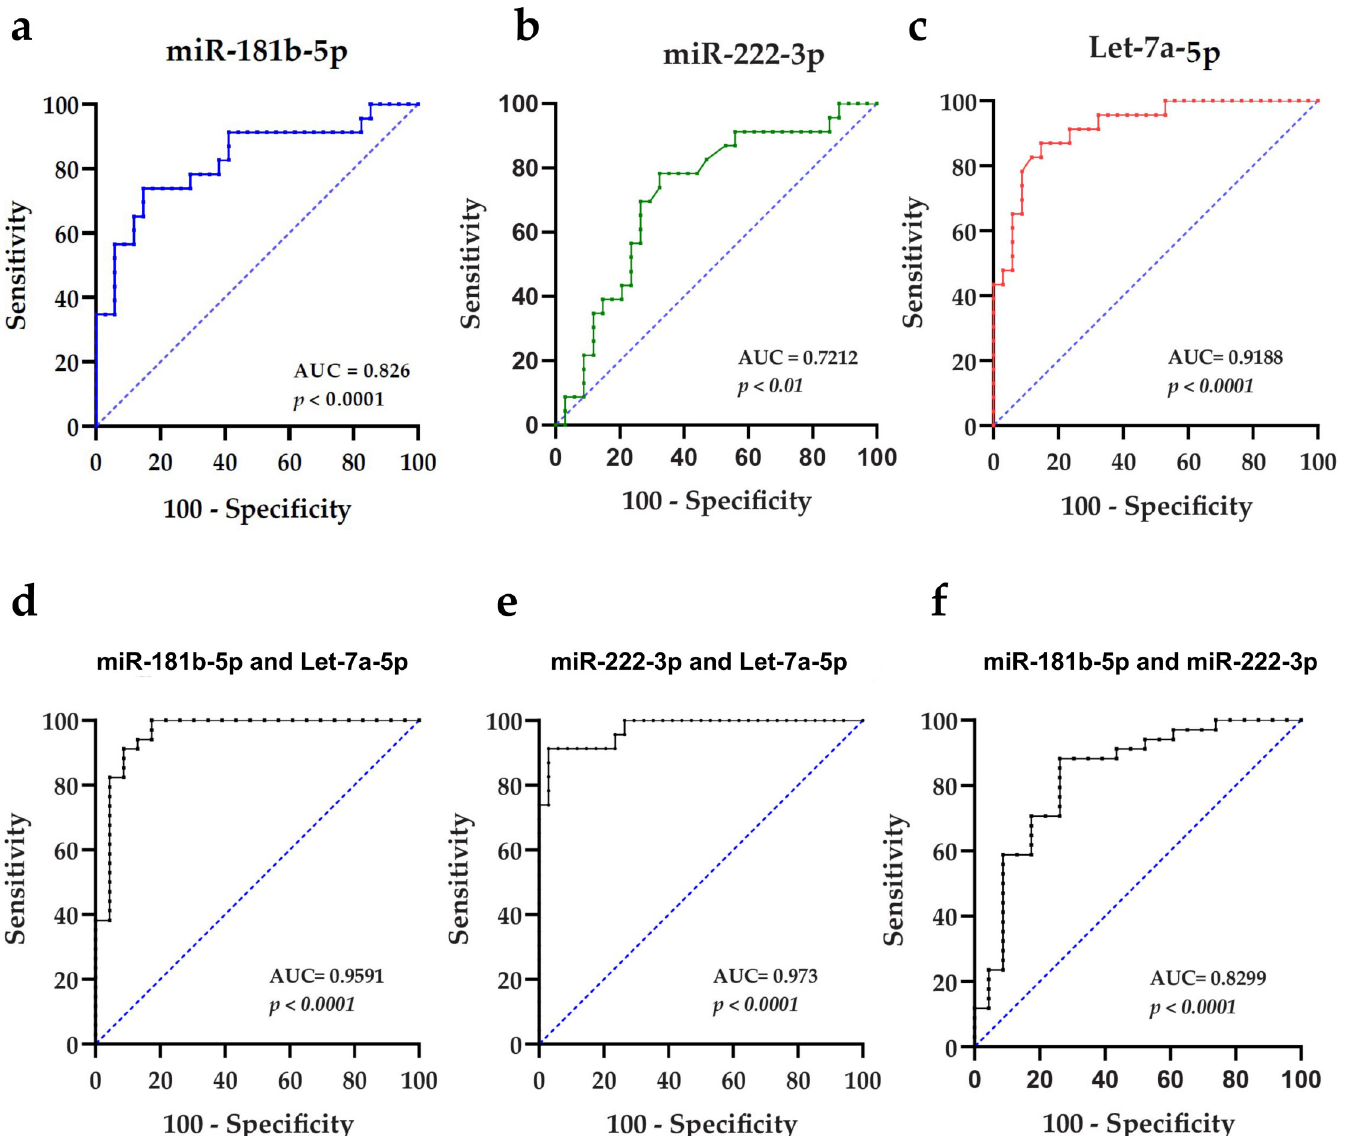
Fig 7. ROC curves generated using expression levels of miR-181b-5p, miR-222-3p, and let-7a-5p. (a-c) ROC curves generated using individual miRNA, namely miR- 181b-5p, miR-222-3p, and let-7a-5p, respectively. (d-f) ROC curves generated using a combination of expression levels of miR-181b-5p and let-7a-5p, miR-222-3p and let-7a-5p, and miR-181b-5p and miR-222-3p as a miRNA panel to discriminate non-IBC and IBC patients, respectively.